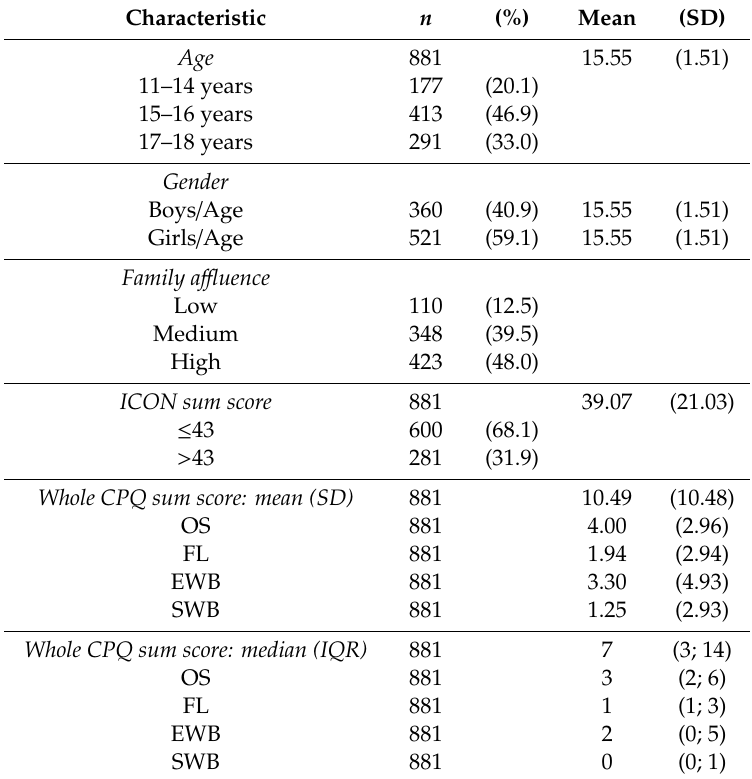
Table 1. Descriptive summary of study participant characteristics for all variables analyzed.